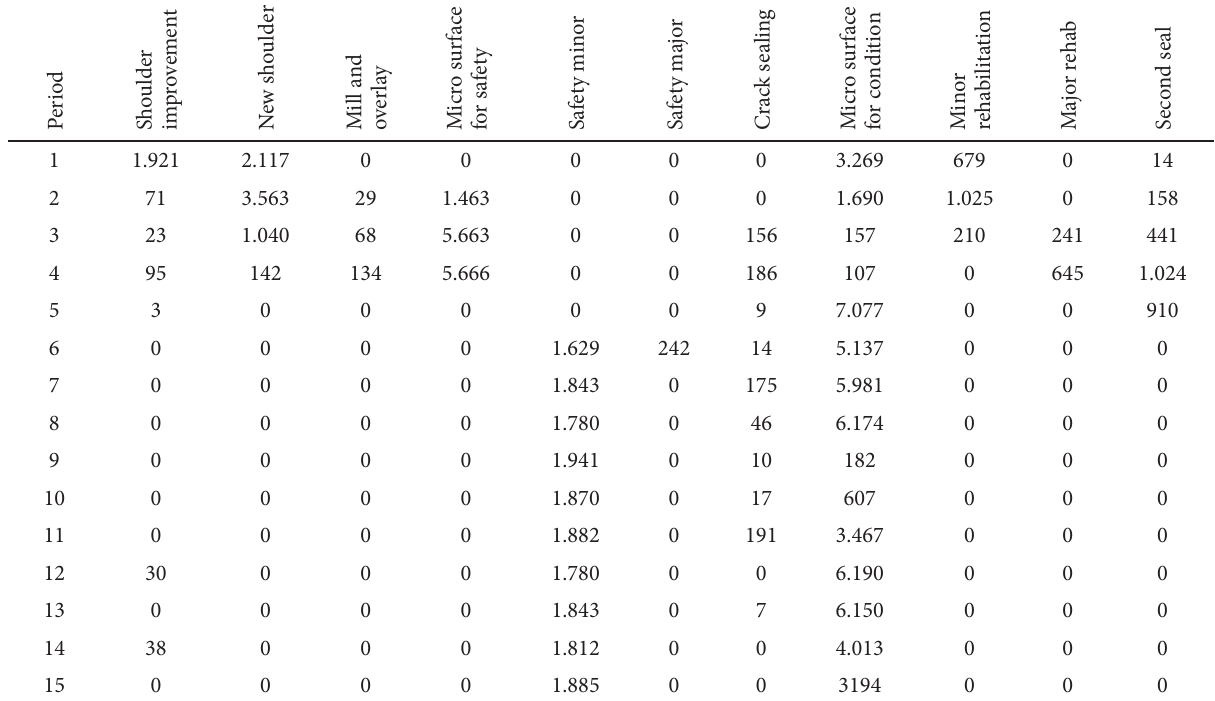
table 4. Investments allocation with 5 mln EUR – Scenario B (in thousands of EUR)